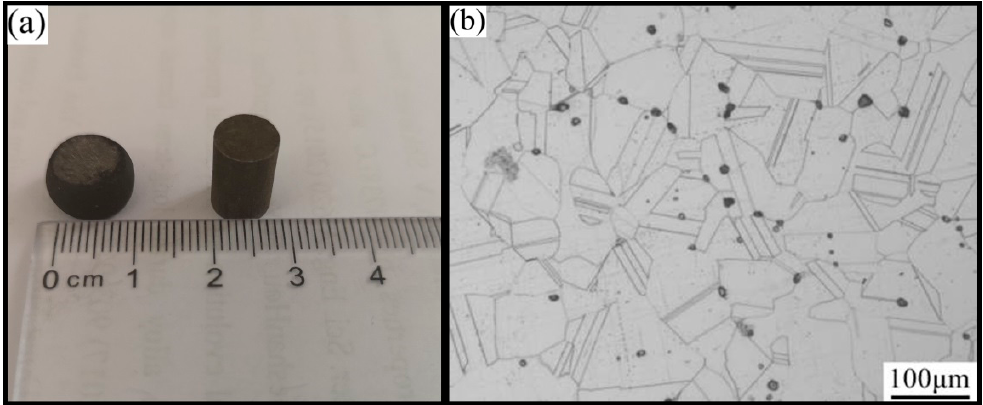
Figure 1. The Inconel625 alloy specimens and original microstructure. ( a )Specimens ( b ) Original microstructure.